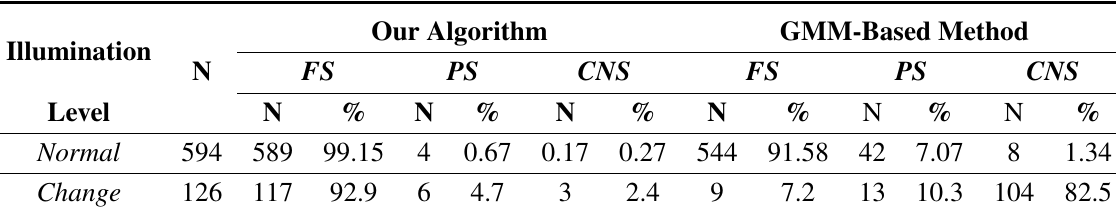
Table 3. The visual evaluation for the light changes by using 720 images in the training data sets. The original images are classified into two illumination levels: Normal and Change . The corresponding segmented binary images are manually classified into three groups.